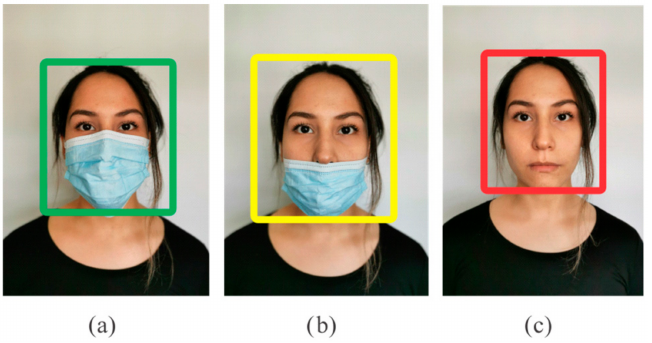
Figure 6. Face mask detection: ( a ) correct use of the face mask; ( b ) incorrect use of the face mask; ( c ) face mask not